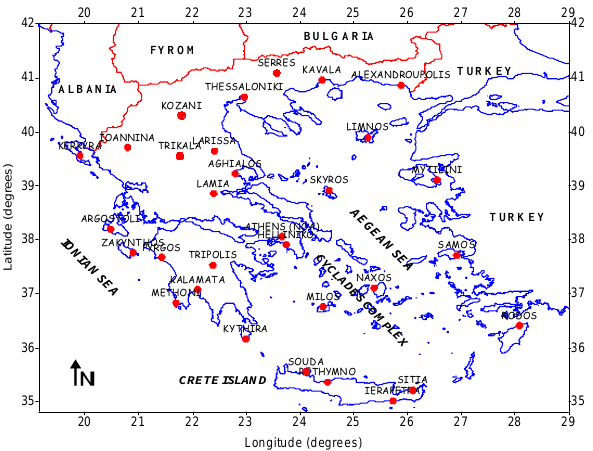
Figure 1 . Meteorological stations from the HNMS network used in the analysis. An even geographical distribution of the stations in the Greek territory is espied.